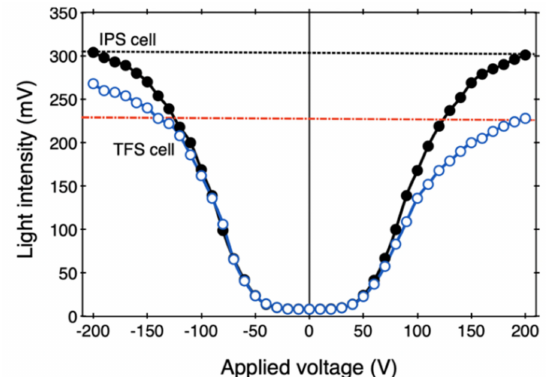
Figure 5. Behavior of the transmitting light intensities in the positive and negative polarities of the applied field in the 10- µ m IPS-BPIII and the 10- µ m TFS-BPIII cells. The frequency of the applied field is 1